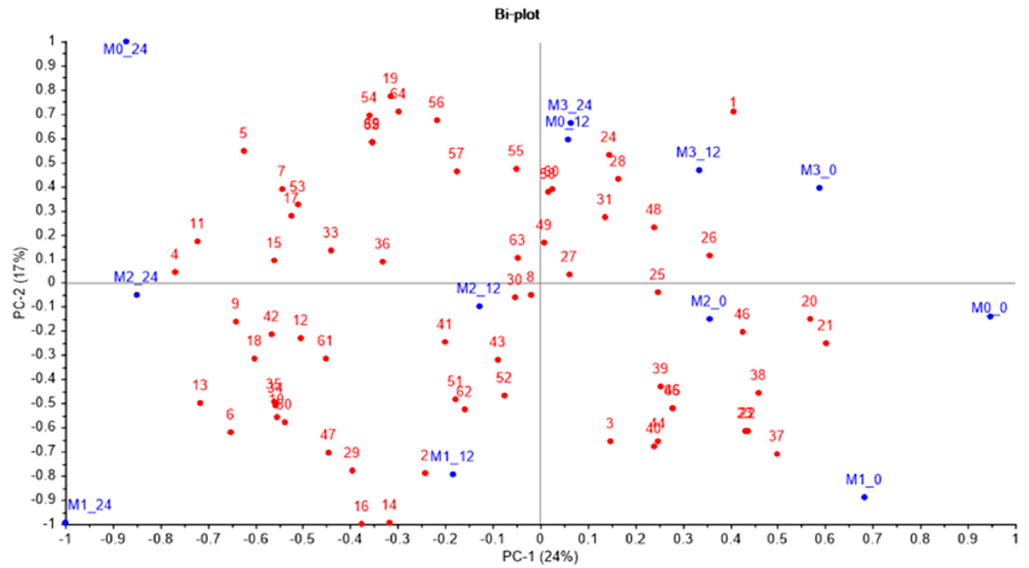
Figure 5. Principal Component Analysis (PCA) biplot of the compounds and parameters identified in sourdough fermented for 0, 12, and 24 h with Lactiplantibacillus plantarum ATCC 8014. (1—Malt-